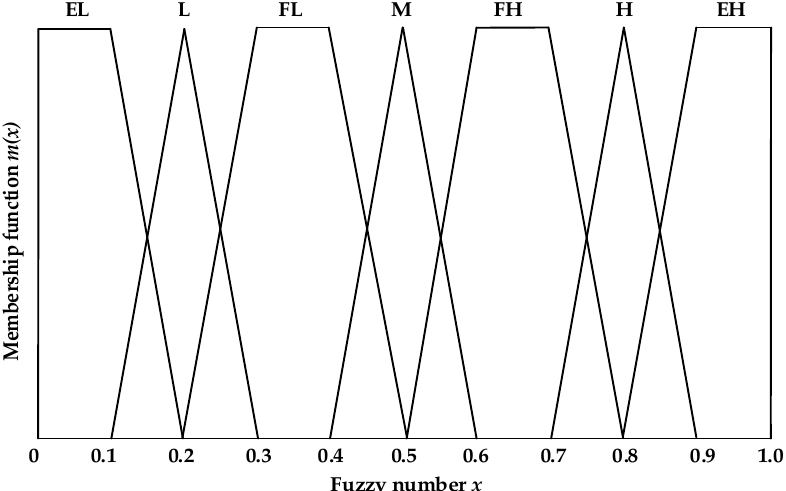
Figure 5. Fuzzy numbers corresponding to linguistic variables.